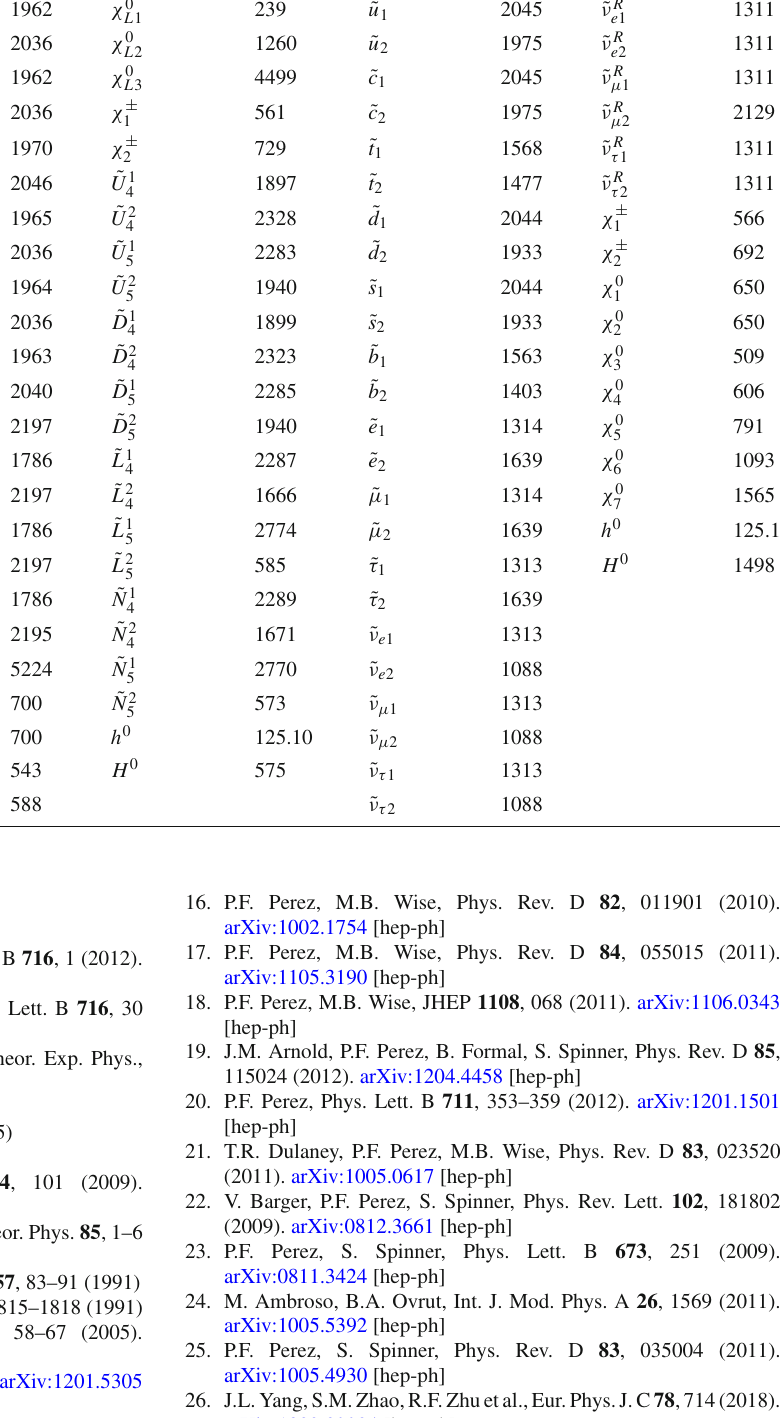
Table 1 The best fit masses (in GeV) for the BLMSSM and B-LSSM